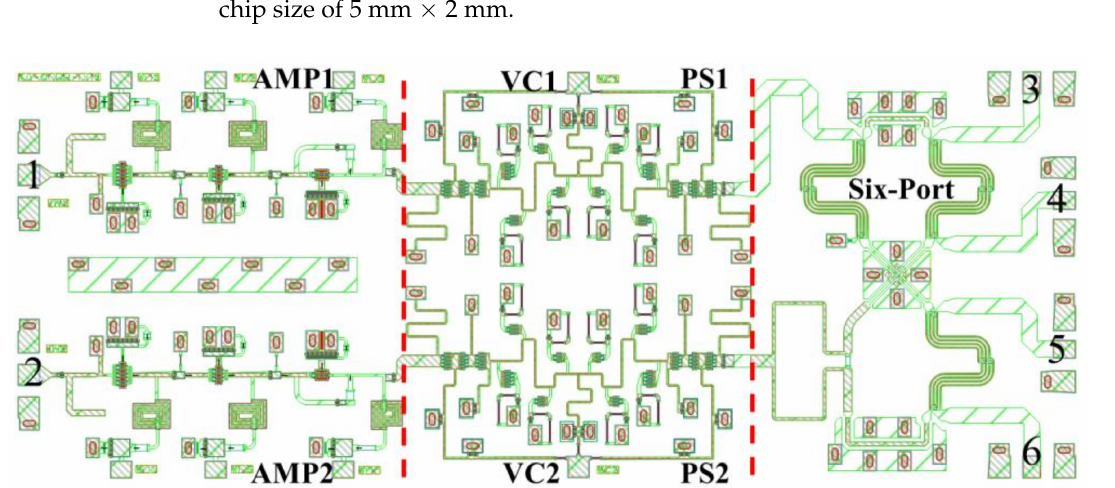
Figure 15. The layout design of the integrated six-port chip with a size of 5 mm × 2 mm. Numbers 1 to 6 represent the port number of the